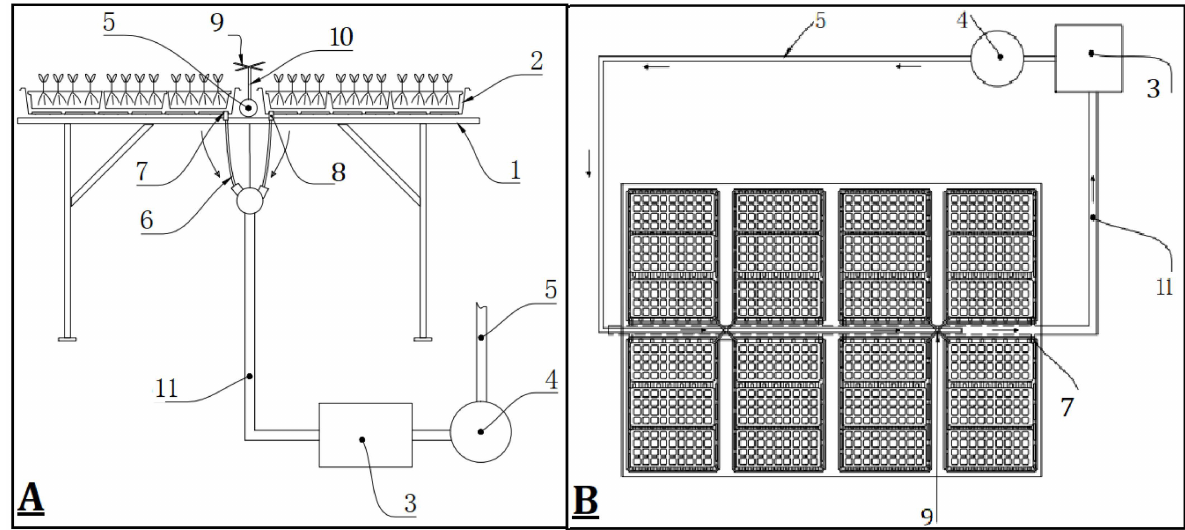
Figure 1. Lateral ( A ) and top ( B ) view of ebb-and-flow nursery raising system. 1—nursery frame; 2—ebb-and-flow tray; 3—water reservoir; 4—disinfection equipment; 5—inlet main pipe; 6—drainage branch pipe; 7—drainage hole; 8—filtering parts; 9—inlet branch pipe; 10—five-way connector; 11—drainage main